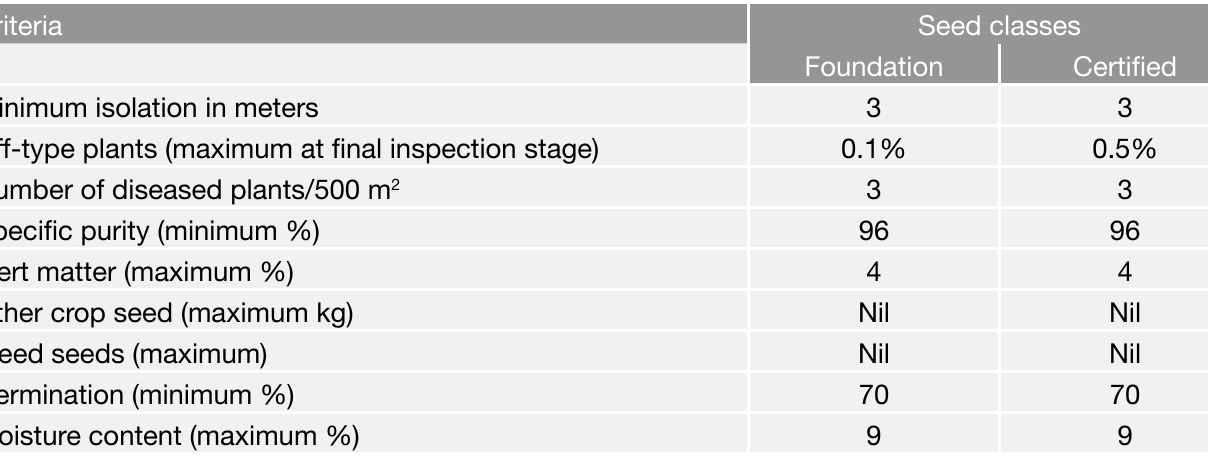
Table 2 : Common seed certification standards for groundnut.